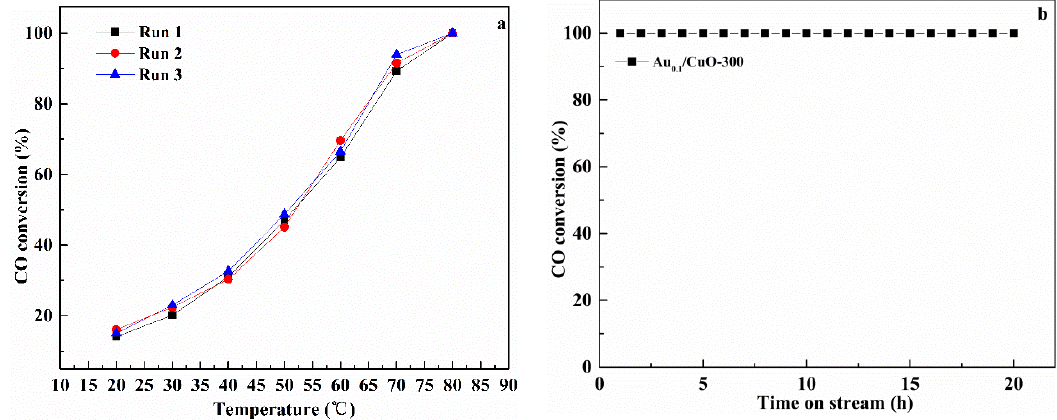
Figure 9. Repeatability of CO oxidation behavior under reaction conditions ( a ) and stability for the CO oxidation at 180 ◦ C ( b ) over Au 1.0 / CuO-300 catalyst.